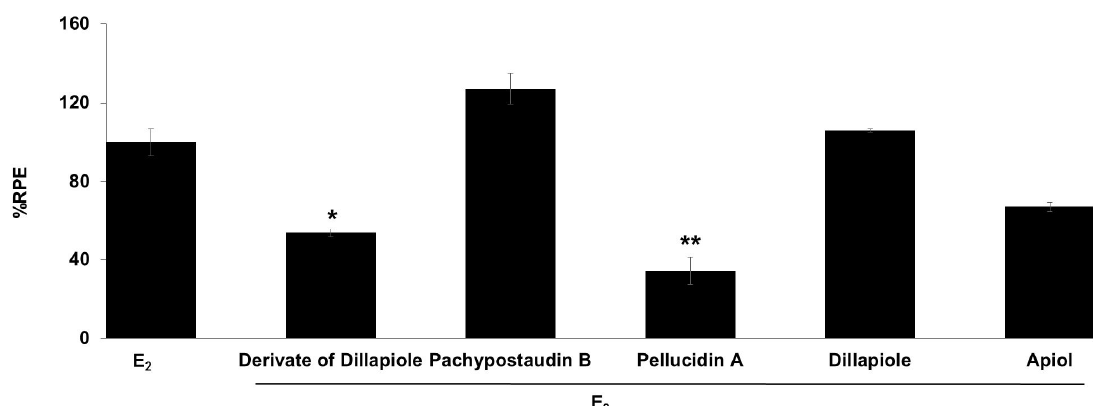
Figure 5. Estrogenic e ff ects of the tested compounds on MCF-7 / BUS cells in the presence of 10 − 9 M E 2 . Cells were treated with estradiol alone or estradiol in combination with 10 µ g / mL of the tested samples for 144 h, and relative proliferative e ff ects on the cells were then investigated using SRB assays. The data are expressed as the mean ± SD of at least two separate experiments in duplicate or triplicate for each group. The symbols * and ** represent statistical di ff erences compared with the estradiol group: * p < 0.05, ** p < 0.01, analyzed by the Kruskal–Wallis test using Bonferroni adjustment.